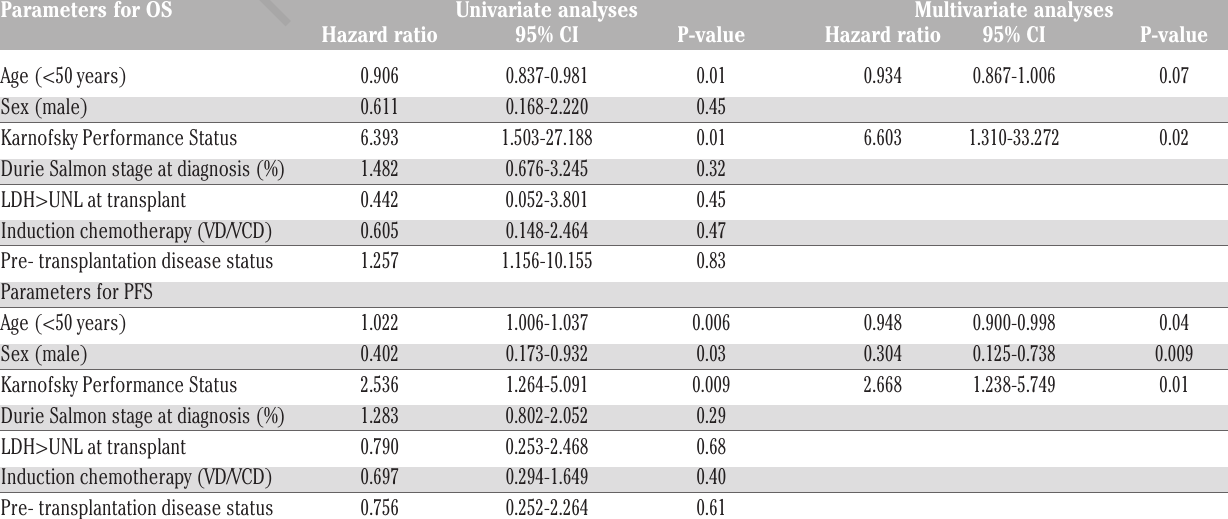
Table 2. Univariate and Multivariate Analyses of Overall Survival and Disease-Free Survival. Parameters for OS